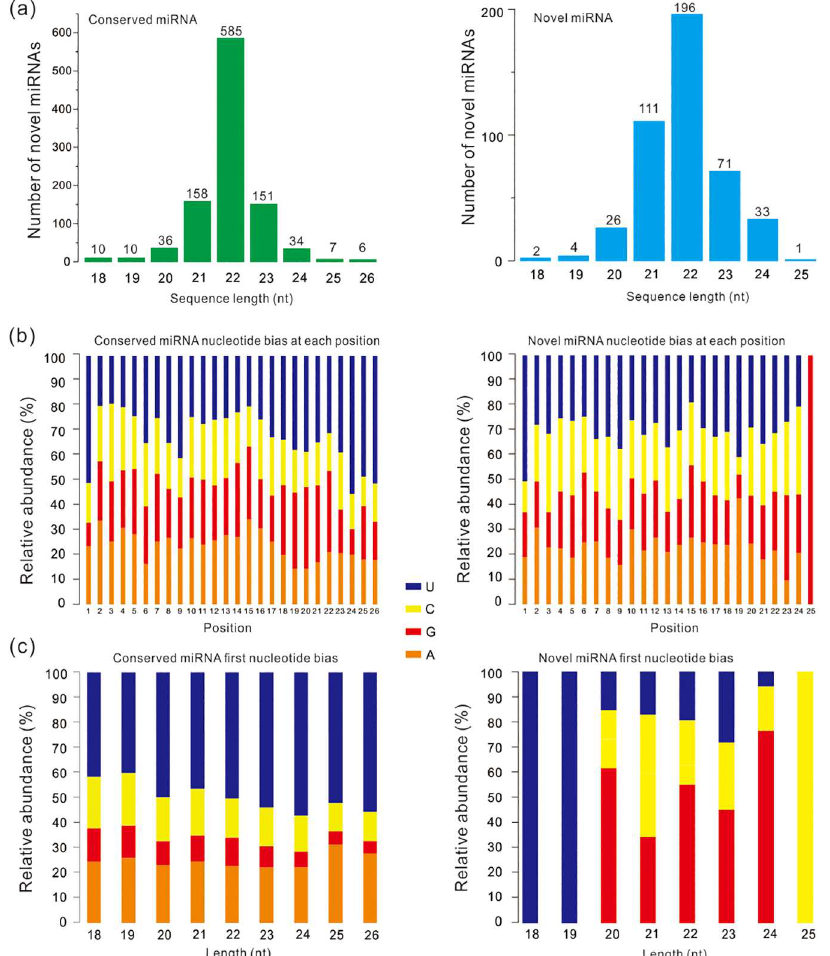
Fig 3. Size distribution and nucleotide bias of conserved and novel miRNAs in G . przewalskii . (a) Size distribution of conservedand novel miRNAs in G . przewalskii . As the percentage of miRNAs, the most abundant miRNAs were 22-nt long. (b) Relativeabundances of conservedand novel miRNA nucleotide bias at each position.The base of conserved and novel miRNAs at each position was most biased toward U. (c) Relativeabundances of first nucleotidebias in conservedand novel miRNAs. The conservedmiRNAs were most biasedtoward U at the first-base position.While the scenariois complex in novel miRNAs, the first-base positionis toward different base for different length of